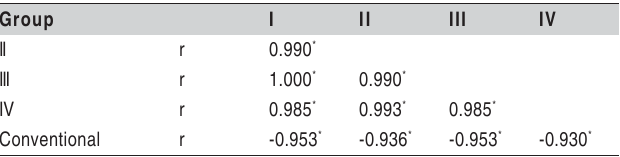
Table 2. Pearson’s correlation coefficient for mean gray value of all the image groups (n=20 per group).